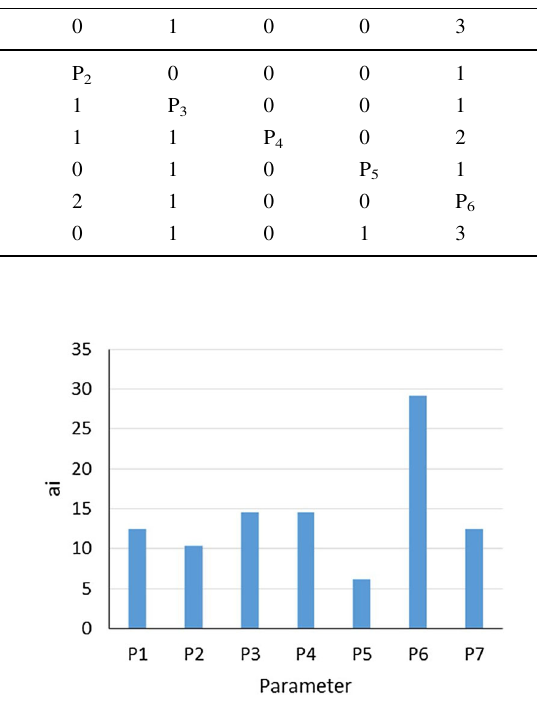
Fig. 3 Weighing of the principal parameters affecting the